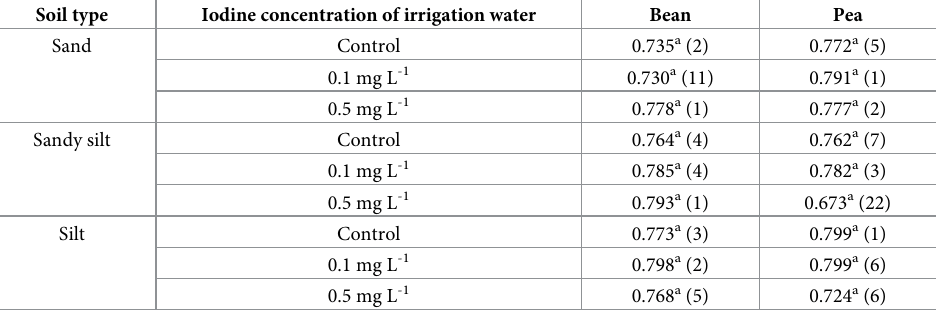
Table 4. Effect of iodine treatments on the maximum quantum efficiency (Fv/Fm) of photosystem (PS) II in bean and pea plants cultivated in different soils. Data shows the mean of three replicates (RSD%), while different letters show statistically significant differences between treatments ( p < 0.05; linear regression and Tukey’s